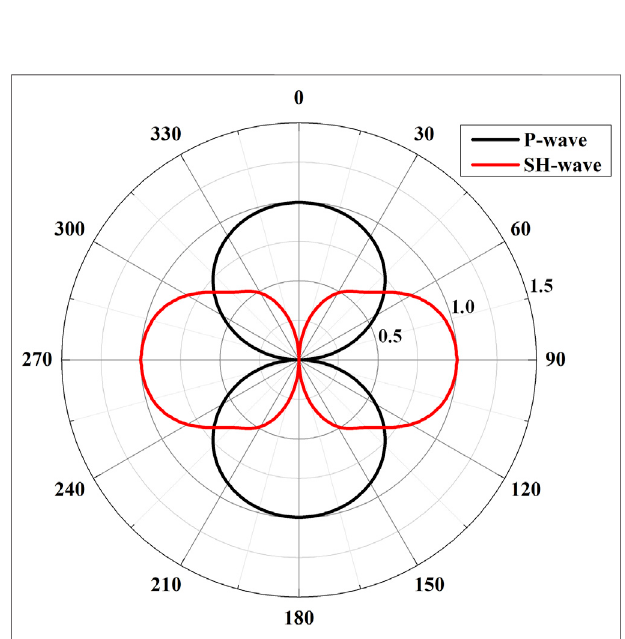
FIGURE 8 | The P-wave (black) and SH-wave (red) radiation patterns in the horizontal plane of a ring dipole source in LWD.